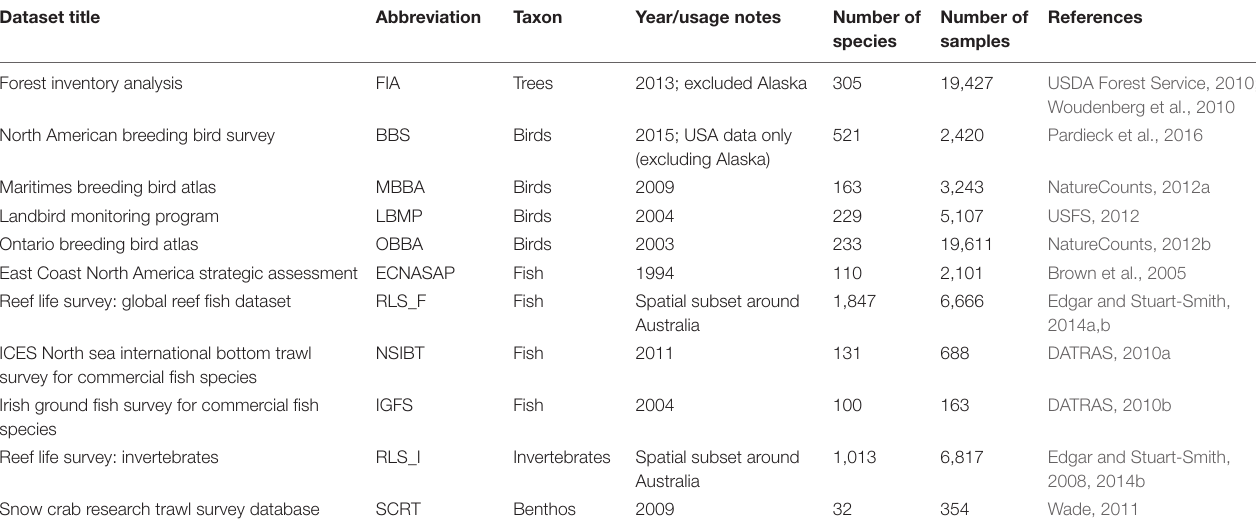
TABLE 1 | Community data used and data